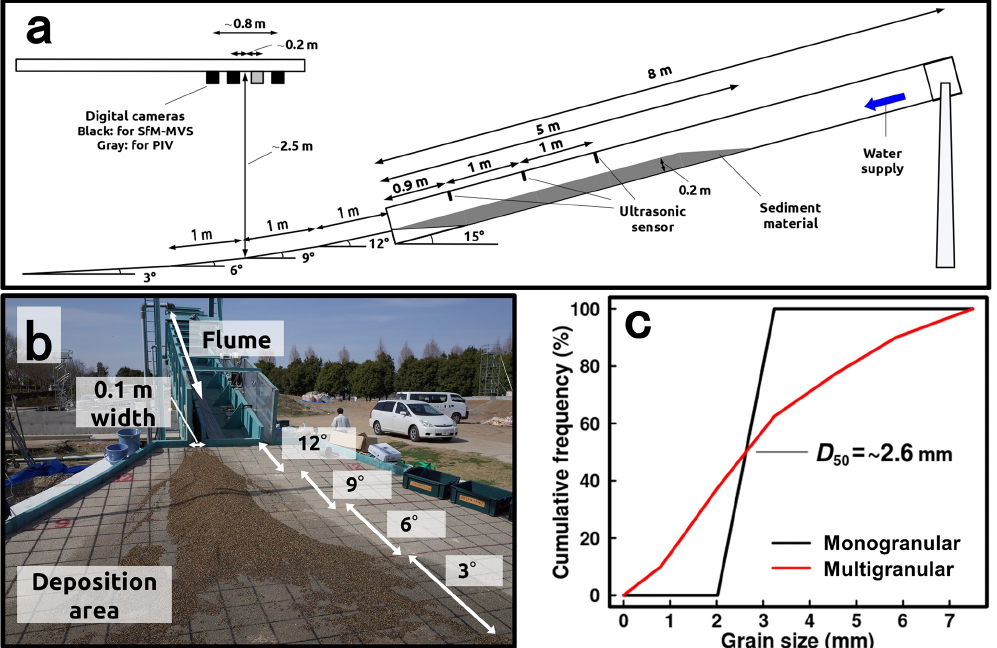
Figure 1. Test flume setup. (a) Dimensions of the test flume and equipment. (b) View of the flume and the deposition area. (c) Grain-size distribution of the sediment materials used in the experiments. Figure modified from Tsunetaka et al.